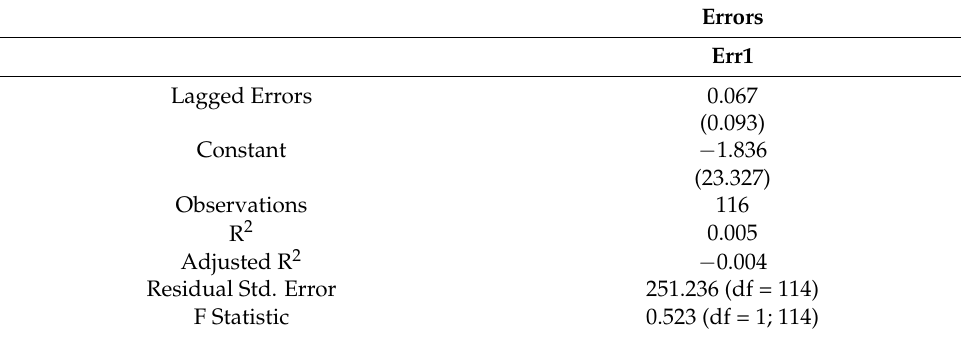
Table 4. Regressions results from error model.